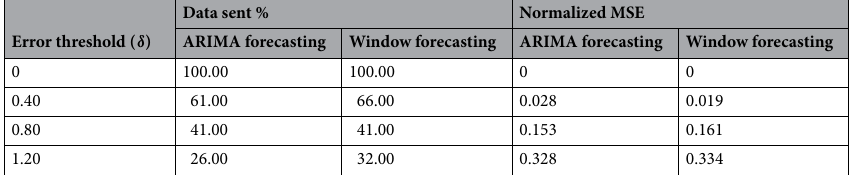
Data sent % Normalized MSE Error threshold ( δ ) ARIMA forecasting Window forecasting ARIMA forecasting Window forecasting